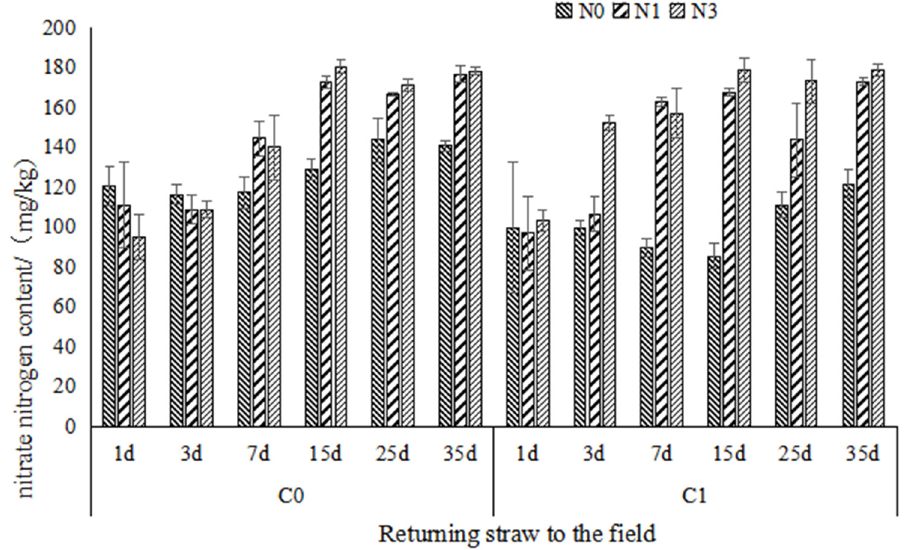
Figure 3. Dynamic changes in the nitrate nitrogen content of saline soil during cultivation.